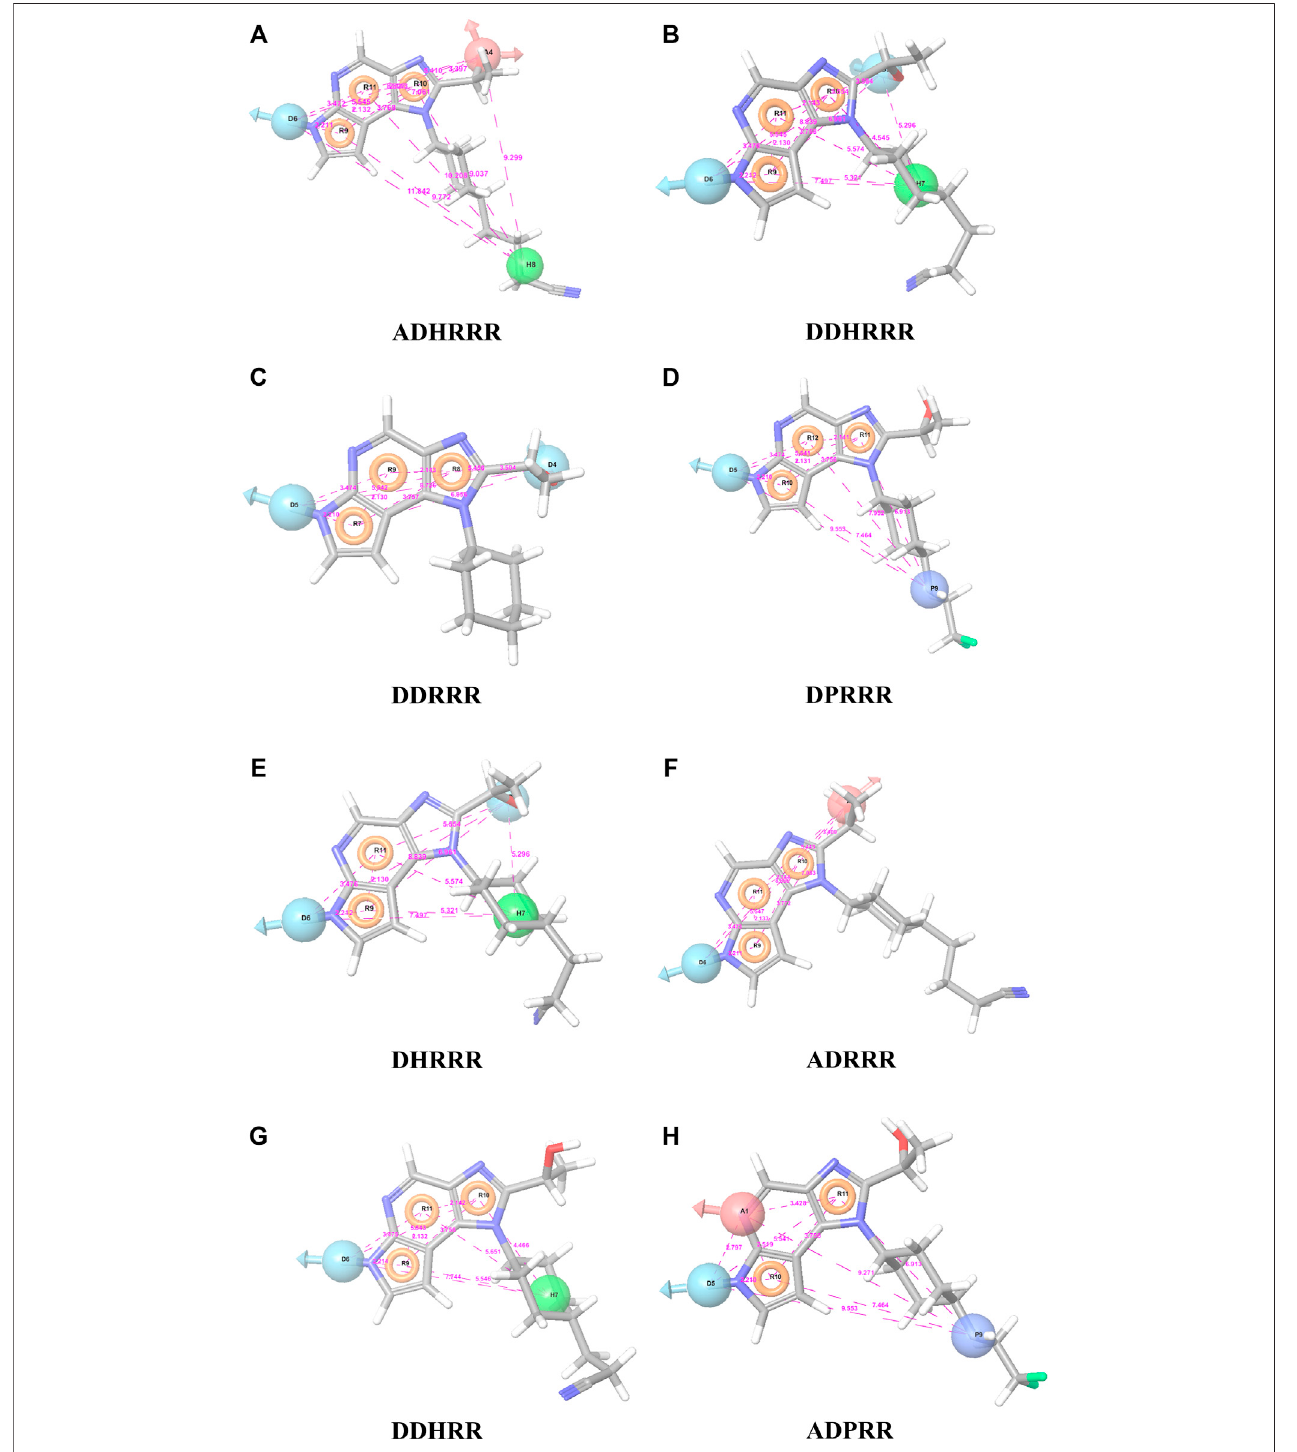
FIGURE 1 | The representation of selected pharmacophore models (A) ADHRRR, (B) DDHRRR, (C) DDRRR, (D) DPRRR, (E) DHRRR, (F) ADRRR, (G) DDHRR, and (H) ADPRR.Pharmacophorefeaturesarecoloredinlightblue,brown,darkblue,brickred,andgreencontoursrepresentingtheH-bonddonor(D),H-bondacceptor (A), positives (P), aromatic ring (R), and hydrophobic (H) groups, respectively. The distances between the pharmacophore features (A ˚ ) are given in pink dotted lines.